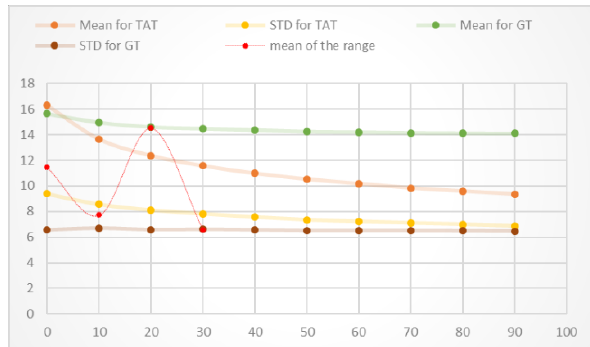
Figure 8. Plot of the resulting mean and std of the check point for both transformations after perturbation of GCPs by ±10m.